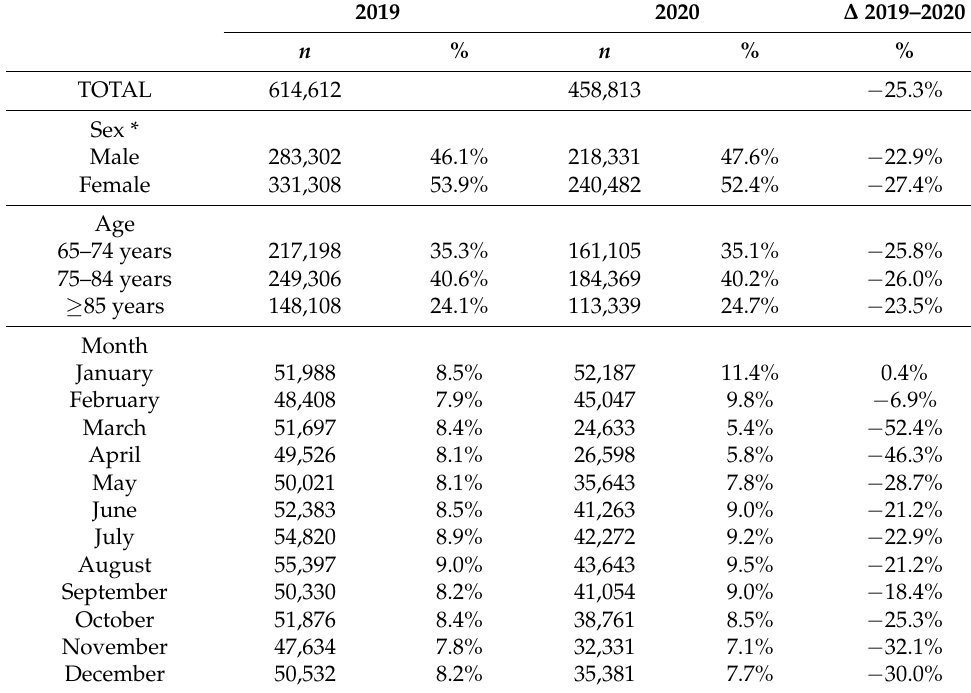
Table 1. Emergency department visits in 2019 and 2020, by gender, age, month, and triage code.